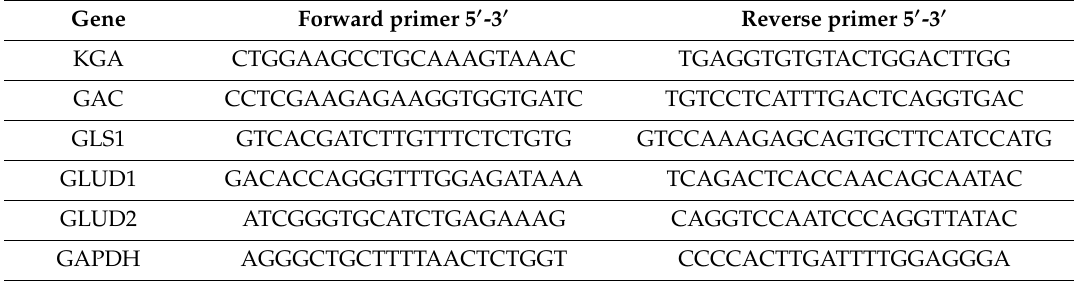
Table 2. Primer sequences used for real-time PCR amplifications.